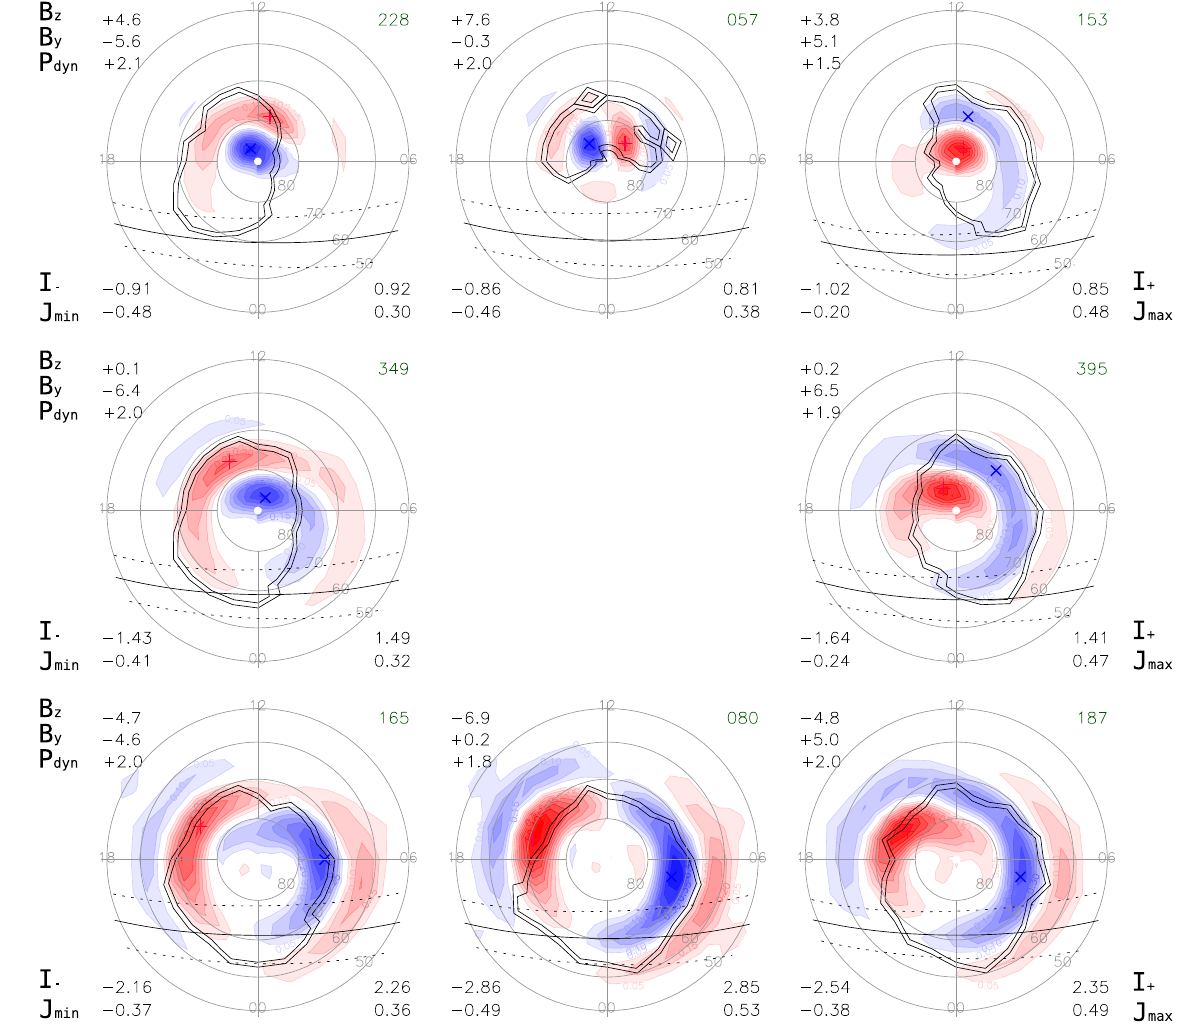
Fig. 5. Northern Hemisphere summer average field-aligned current distributions for | B IMF | > 4. For full figure description see Fig.